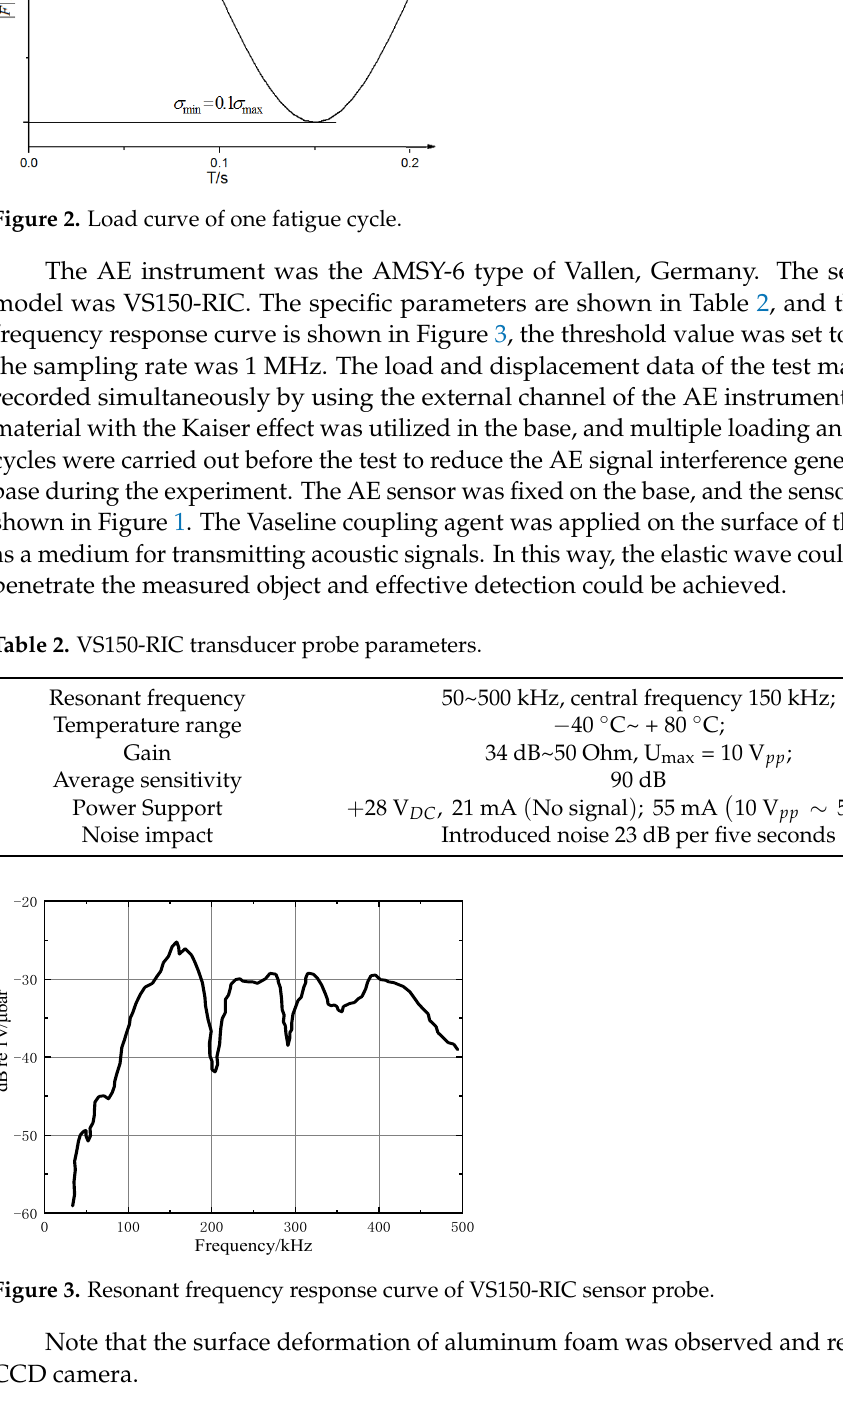
Figure 1. Experimental process.